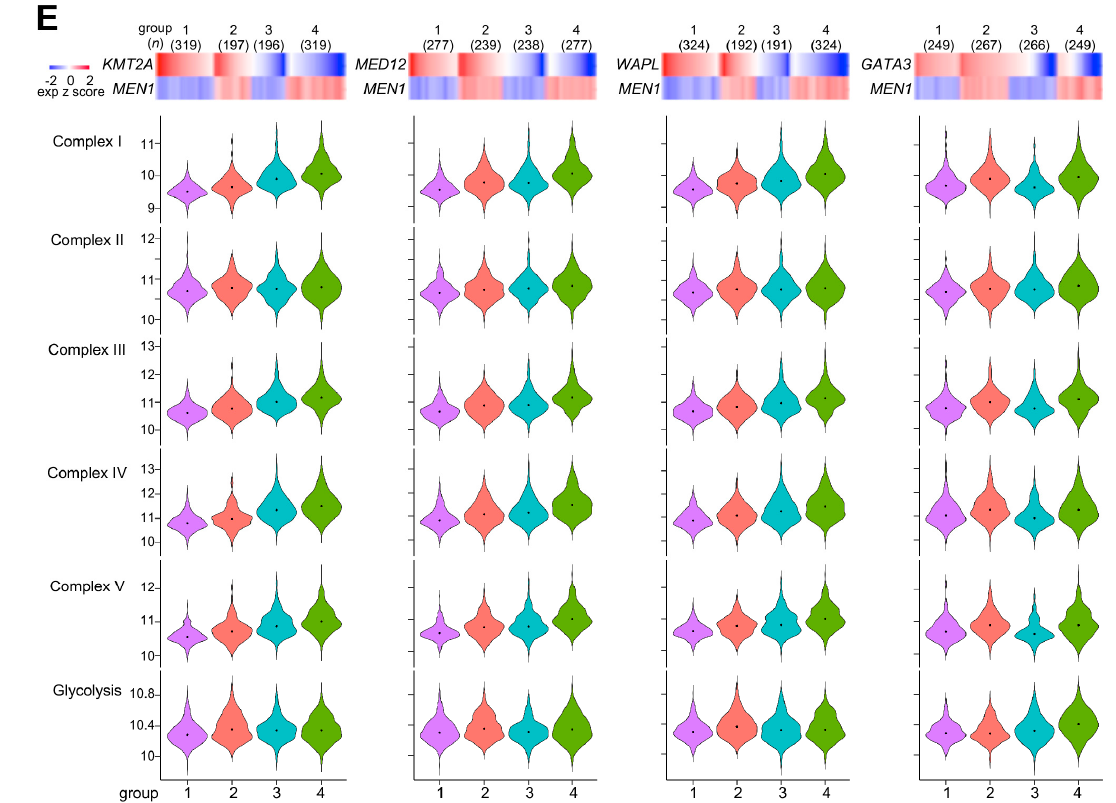
Figure 3. Expression correlation relationship of menin / MAPs genes and OXPHOS / glycolytic genes. ( A ) Workflow of the in silico correlation analysis of gene expression in The Cancer Genome Atlas (TCGA) breast cancer cohort. ( B ) Heatmaps of the expression correlation between MEN1 / selected 4 MAP genes and OXPHOS genes (upper) or glycolytic genes (lower) in normal (N) and tumor (T) samples. The genes are arranged from the highest to the lowest according to gene expression correlation coe ffi cients of MEN1 –OXPHOS genes or MEN1 –glycolytic genes in breast tumors. ( C ) and ( D ) Scatter plots and linear regression analyses of MEN1 / selected MAPs expression and mean expression of OXPHOS genes ( C ) or glycolytic genes ( D ) in normal and tumor samples. ( E ) Violin plots (lower panel) shows the average expressions of the genes of OXPHOS complexes I-V and glycolysis in the samples of each of the corresponding 4 groups are shown as violin plots. Based on the median values (where ≥ median is “high” and < median is “low”) of the expression of the corresponding individual genes ( KMT2A , MEN1 2, WAPL , and GATA3 ) and MEN1 , the TCGA breast tumor samples were divided into 4 groups—1: high-low, 2: high-high, 3: low-low, and 4: low-high (upper panel). Letters on top of the violin plot denote statistical significance, where two groups with di ff erent letters are significantly di ff erent ( p < 0.05) and those with the same letter are